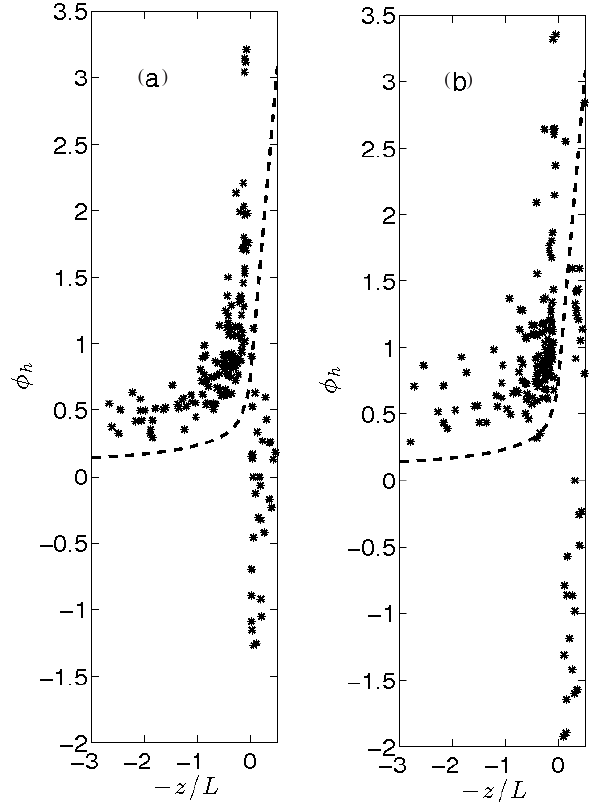
Figure 5. Dimensionless temperature gradient ( φ h ) as a function of − z/L at 2.23m on (a) 30 June and (b) 1 July 2011. Dashed line is the approximation of Businger et al.